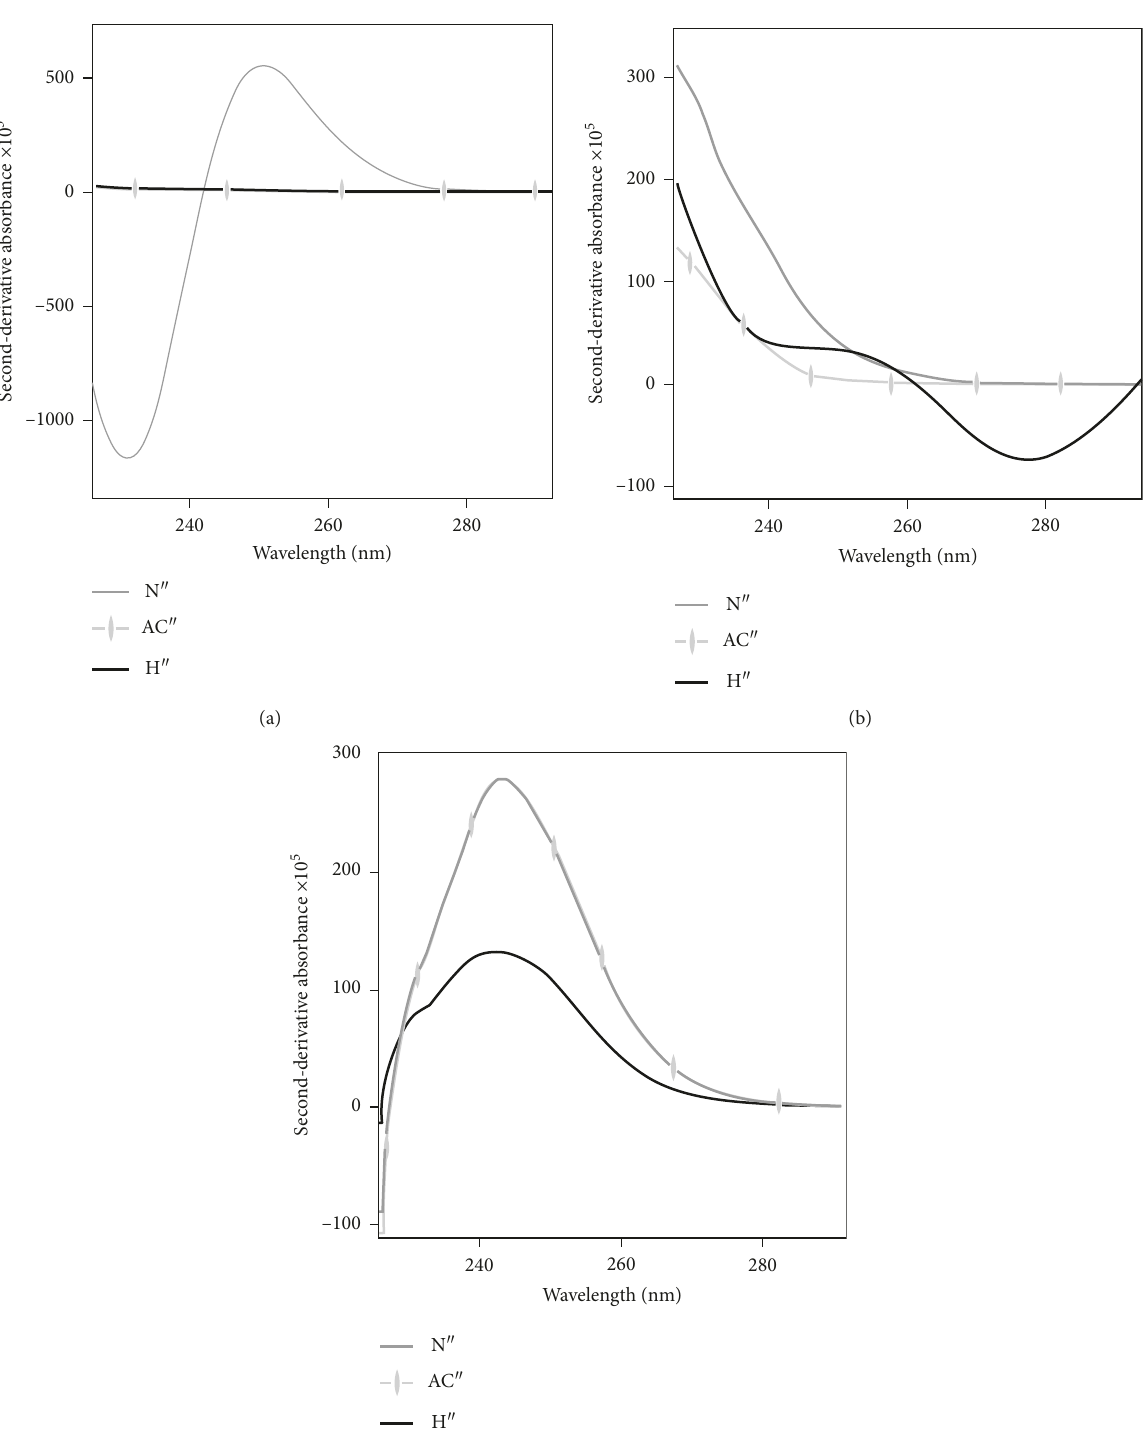
Figure 2: Second-derivative absorbance spectra ( N 0 , AC 0 , and H 0 ) for (a) sulfides (Na solution at 490 µ mol/L), and (c) thiosulfates (Na 2 S 2 O 3 solution at 500 µ mol/L) between 220 and 300nm at 25 ° C in three different buffered media ( H , pH 1.0; AC , pH 4.7; and N , pH 9.2). Note that H 0 and AC 0 spectra merge in (a) while N 0 and AC 0 are superposed in (c). (cid:30) (cid:30) (cid:30) Sulfides display a maximum at 250nm for a pH of 9.2 ( N 0 ), while a minimum is reached for sulfites at 278nm for a pH of 1 ( H 0 ). For thiosulfates, maxima are found at 244nm for the three media ( N 0 , H 0 , and AC 0 ). Optical path length and